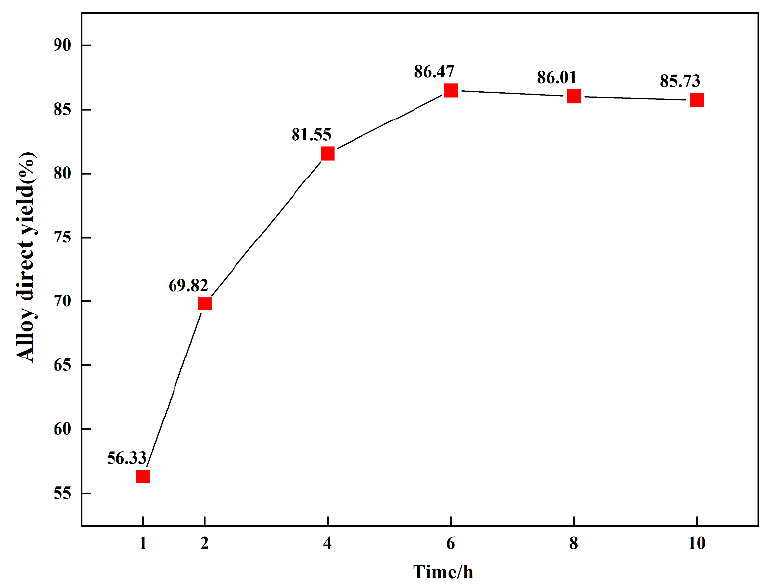
Figure 11. Direct yield of the manganese-silicon alloy with varying holding times. The volatilization rate of lithium with varying reduction times is shown in Figure 12. There was a large increase in 2–4 h, which further verified the conclusion that LiAlSi 2 O 6 was considerably reduced with reaction times of 2–4 h. Upon extending the time, the volatilization rate of lithium increased gradually. When the reduction time was 6 h, the volatilization rate of lithium reached 97.65%, and the reduction of lithium was complete.